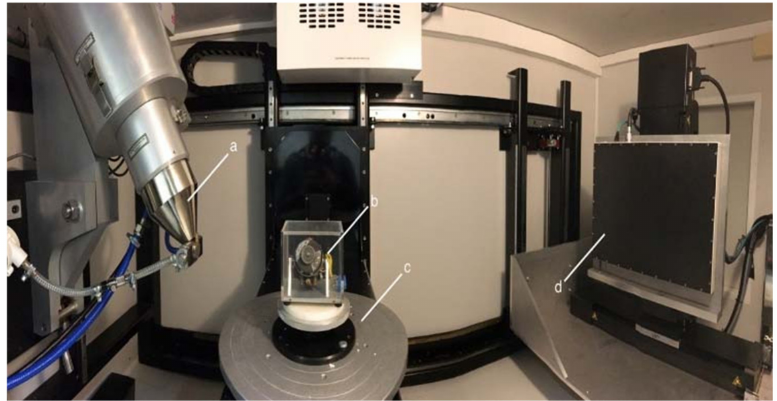
Figure 8. Measurement setup in CT: ( a ) X-Ray tube; ( b ) object to be scanned; ( c ) rotation table; and ( d ) flat panel detector.